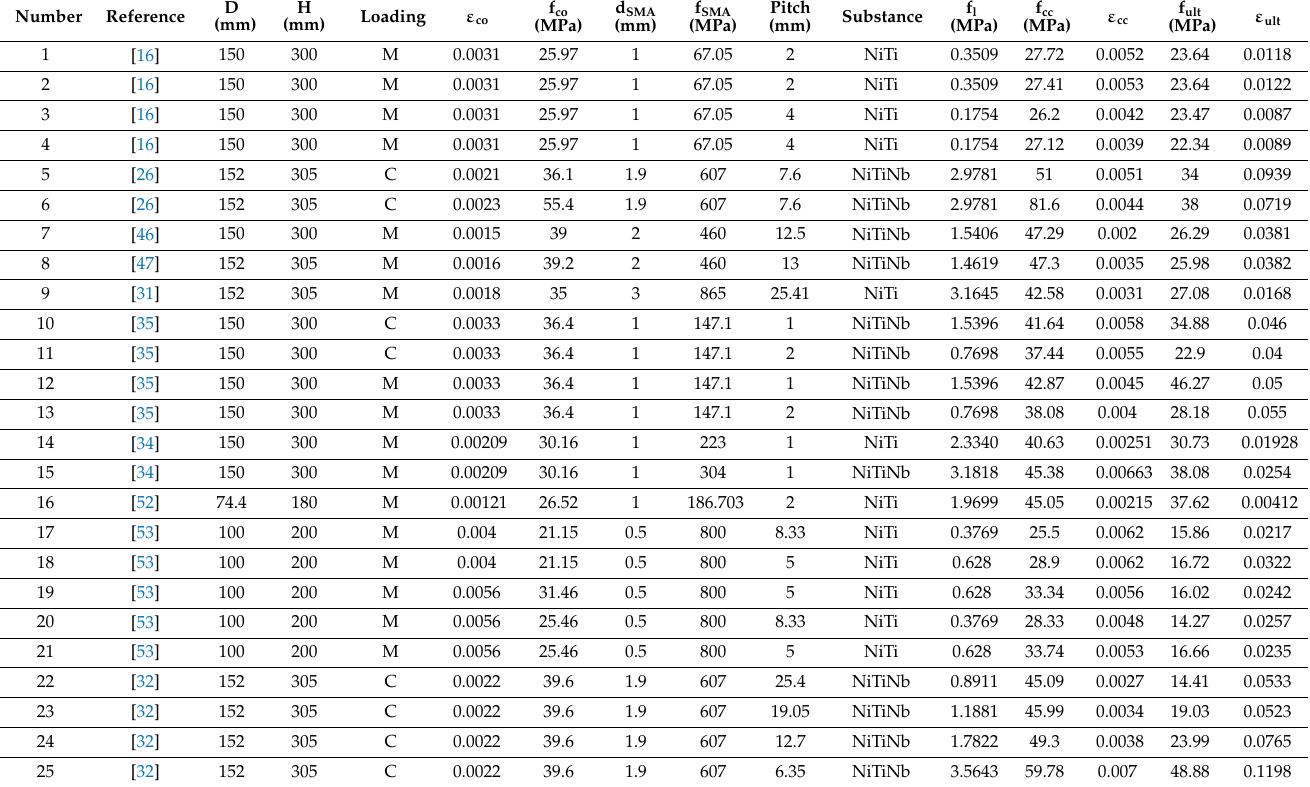
Table 1. Experimental database of cylindrical specimens confined with SMA